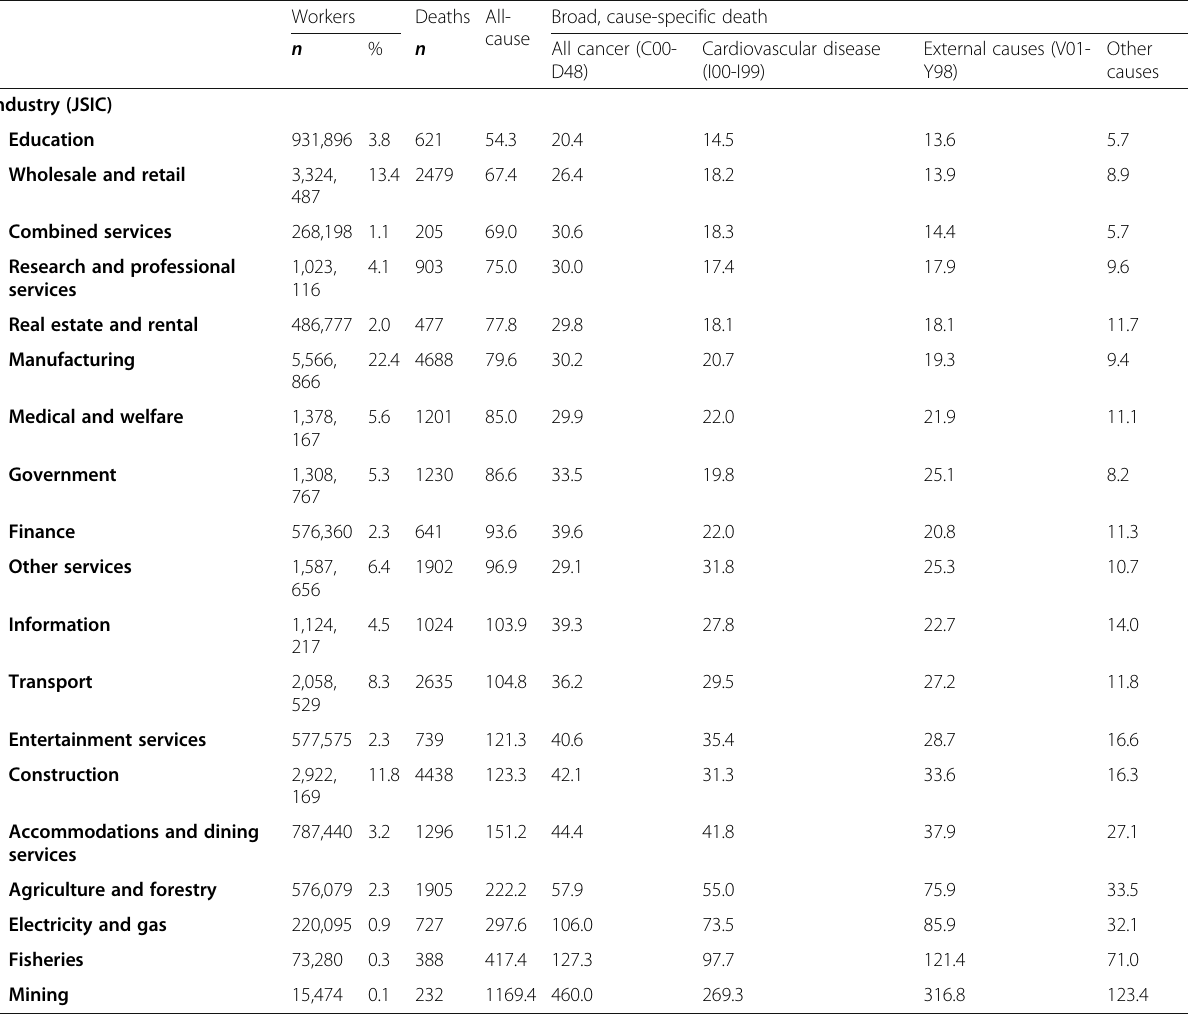
Table 3 Age-standardized mortality rates by industry in Japan during the 2015 fiscal year (per 100,000 population, males aged 25 – 64 years (among workers aged 25 – 64 years in the National